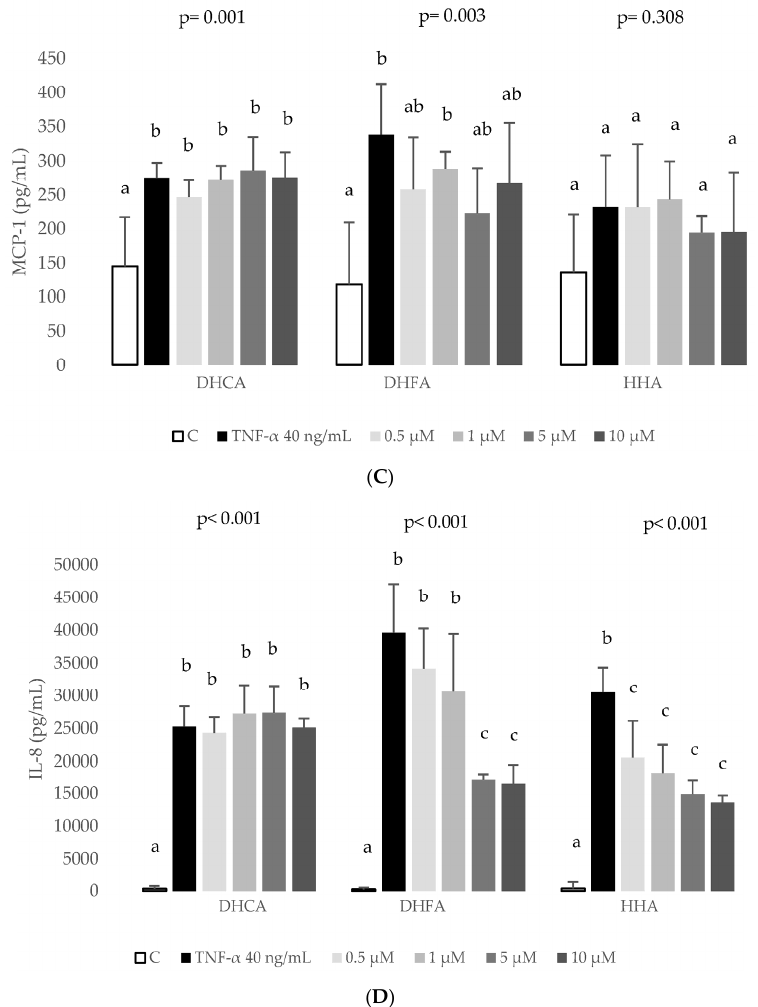
Figure 5. Effect of coffee microbial metabolites DHCA, DHFA, and HHA at 0 (C), 0.5, 1, 5 and 10 µM with cotreatment of TNF- α at 40 ng/mL during 6 h on the production of interleukin-6 (IL-6; A ), macrophage inflammatory protein 1 (MIP-1 β ; B ), monocyte chemoattractant protein 1 (MCP-1; C ) and interleukin-8 (IL-8; D ) in HepG2 cells. Results, expressed as pg/mL, are means ± SD (n = 4). The p values above the figures represent ANOVA results and different letters denote statistical differences according to the Bonferroni test within the same compound ( p < 0.05).